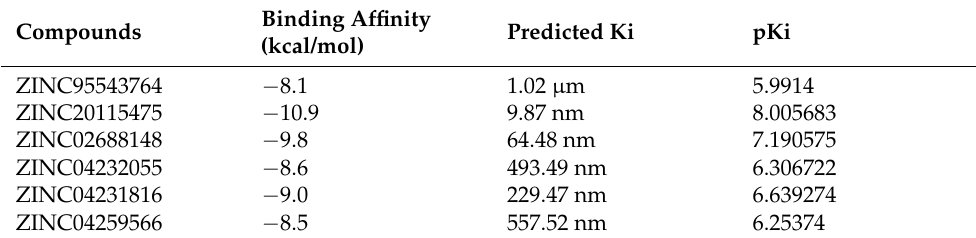
Table 3. The predicted binding affinities and Ki values for